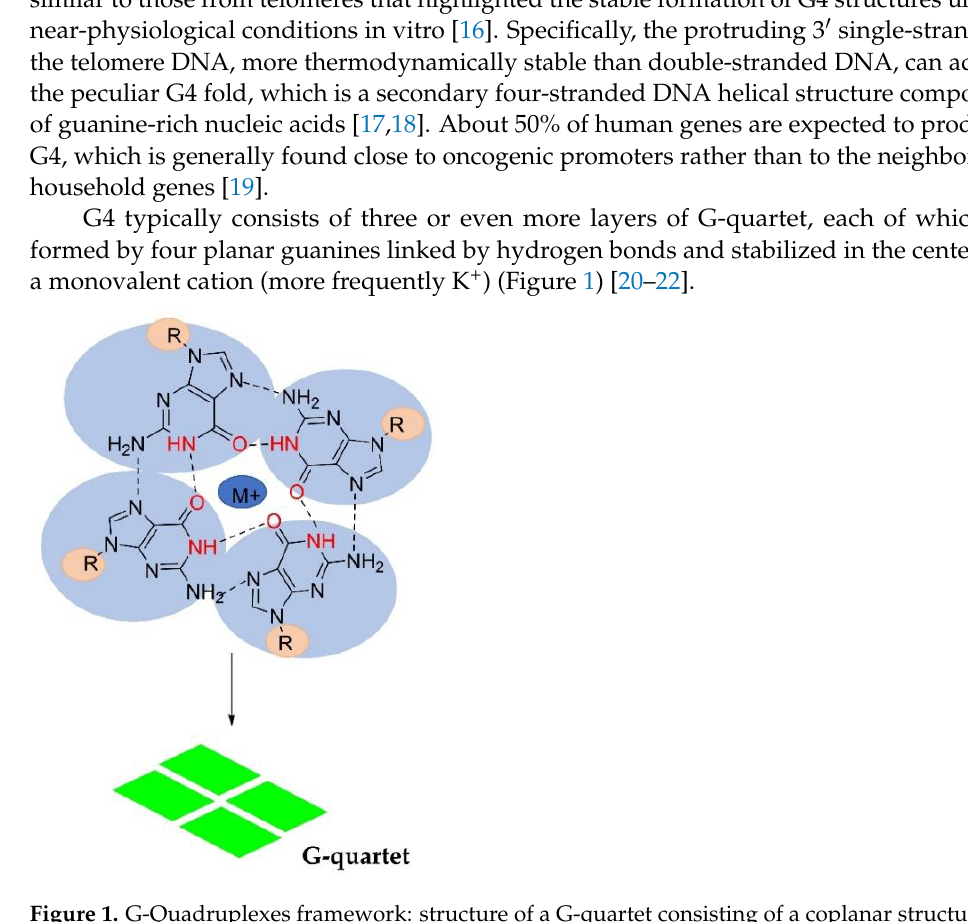
Figure 1. G-Quadruplexes framework: structure of a G-quartet consisting of a coplanar structure of four guanines bound with their N1 and O6 (outlined in red) and stabilized by a central monovalent metal cation (M + ).